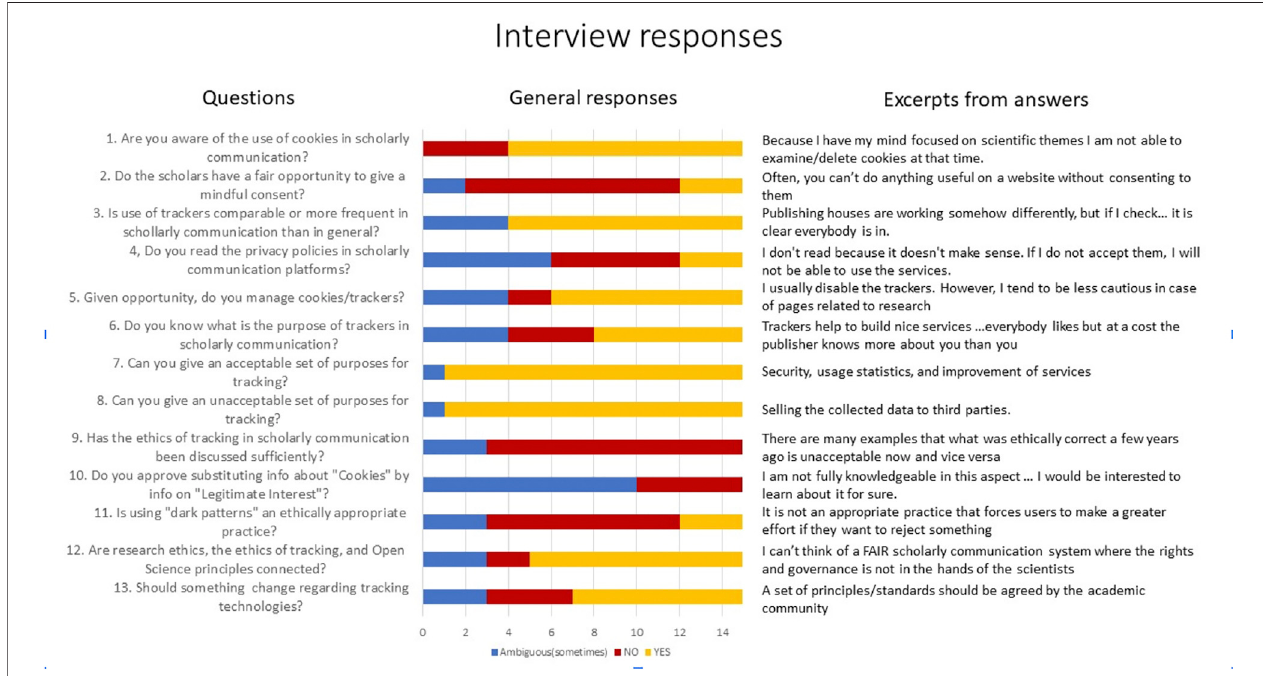
FIGURE 2 | The result of interviewing 15 experts of scholarly